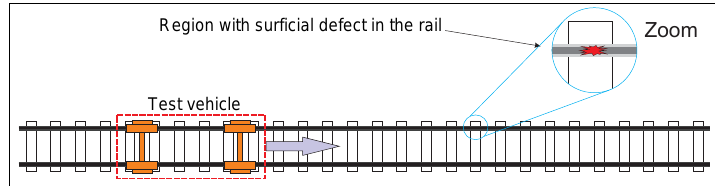
Figure 4. Vehicle track monitoring process